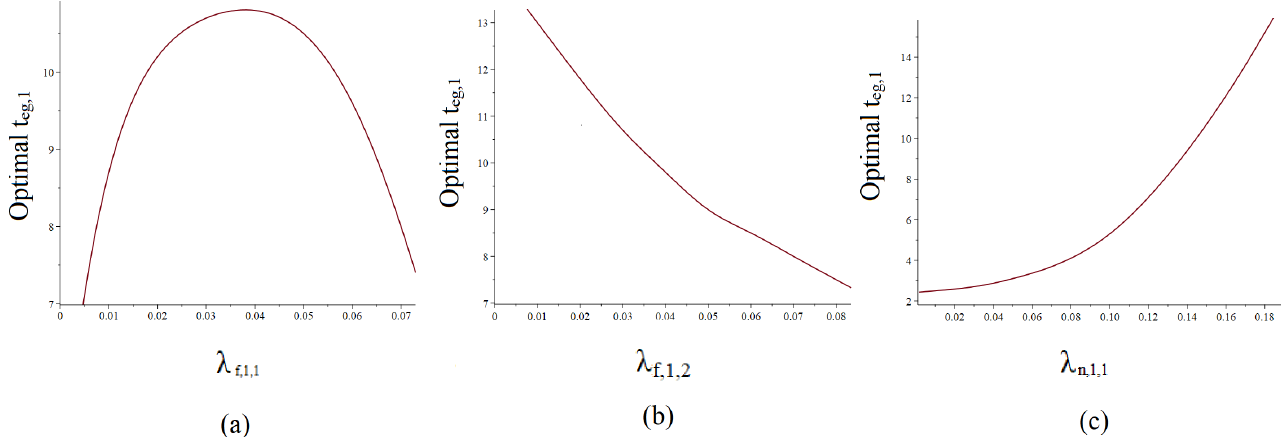
Figure 8. Sensitivity of optimal t eg ,1 to the arrival rates of ( a ) freight vehicles on the main road, ( b ) freight vehicles in one lane of the main road, and ( c ) regular